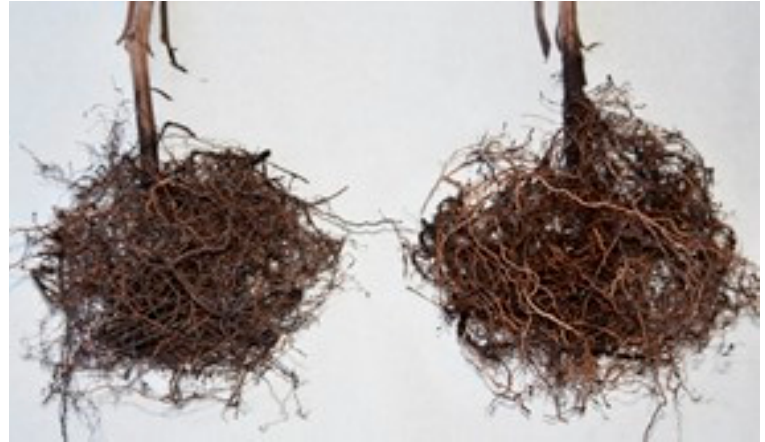
Figure 2. Root browning sixty days after the beginning of Cr(VI) treatment (left: Cr(VI) treatment; right: control).